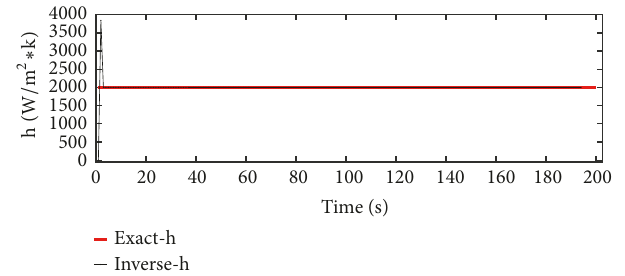
Figure 9: The heat transfer coefficient of the measuring point without error.